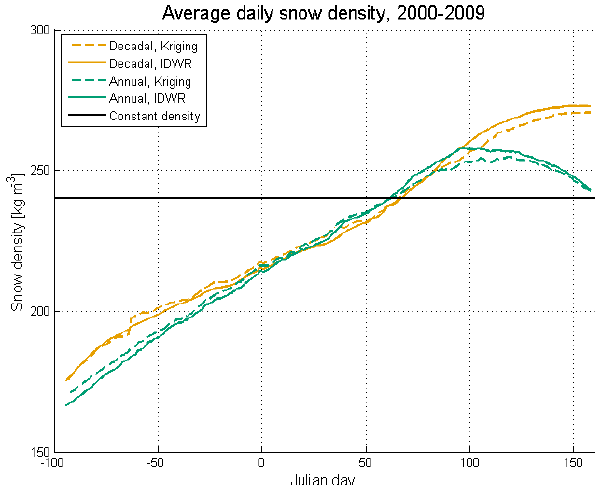
Figure 3. Average daily snow density between 2000–2009 for four different snow density versions. The constant snow density used in SWE retrieval procedure is also